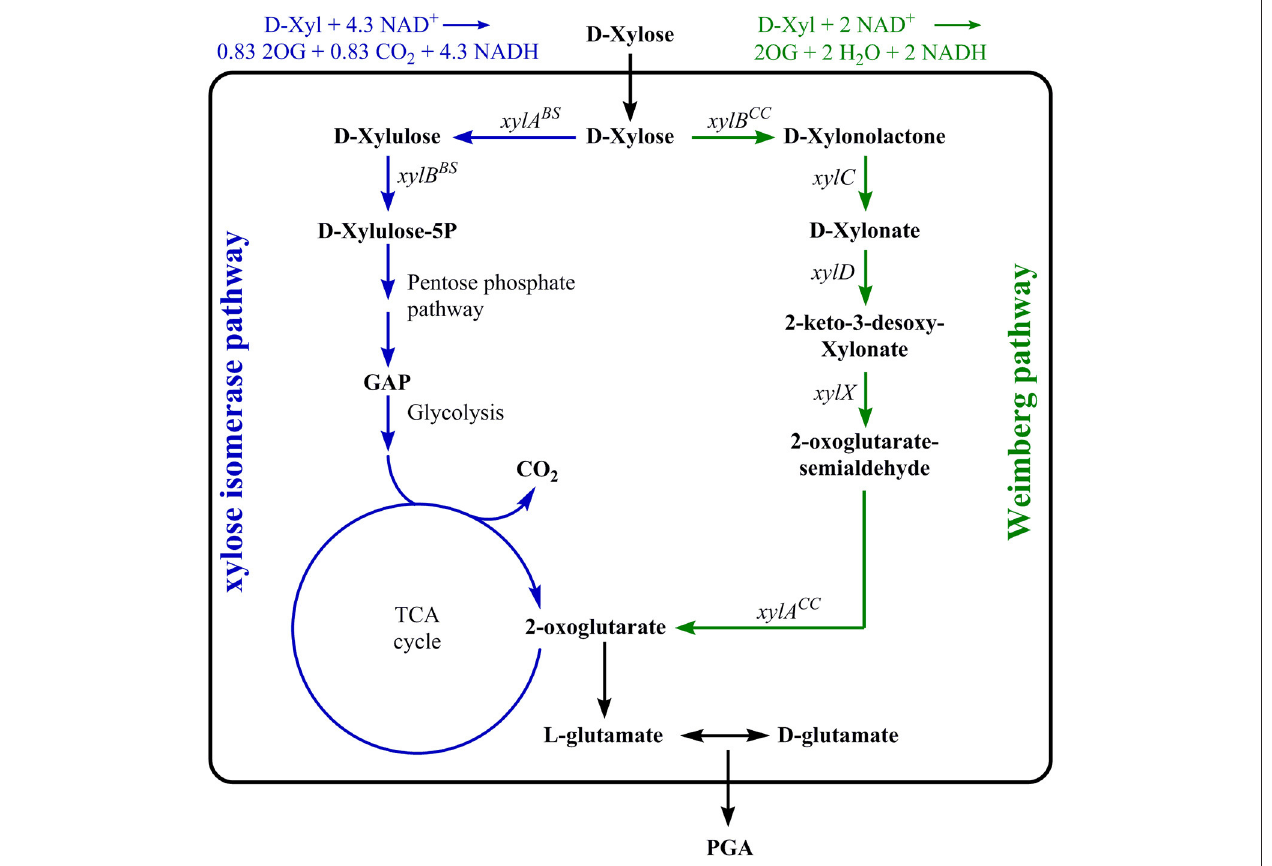
FIGURE 1 | Metabolic pathways for γ -PGA production with xylose utilization. The isomerase pathway (blue) is natively present in Bacillus subtilis . The genes xylA and xylB encode the xylose isomerase and xylulokinase, respectively. These enzymes convert xylose to xylulose-5-phosphate, a pentose phosphate pathway (PPP) intermediate. The Weimberg pathway as present in Caulobacter crescentus (green) consists of five genes, xylA , xylB , xylC , xylD, and xylX . It is a linear pathway converting xylose to